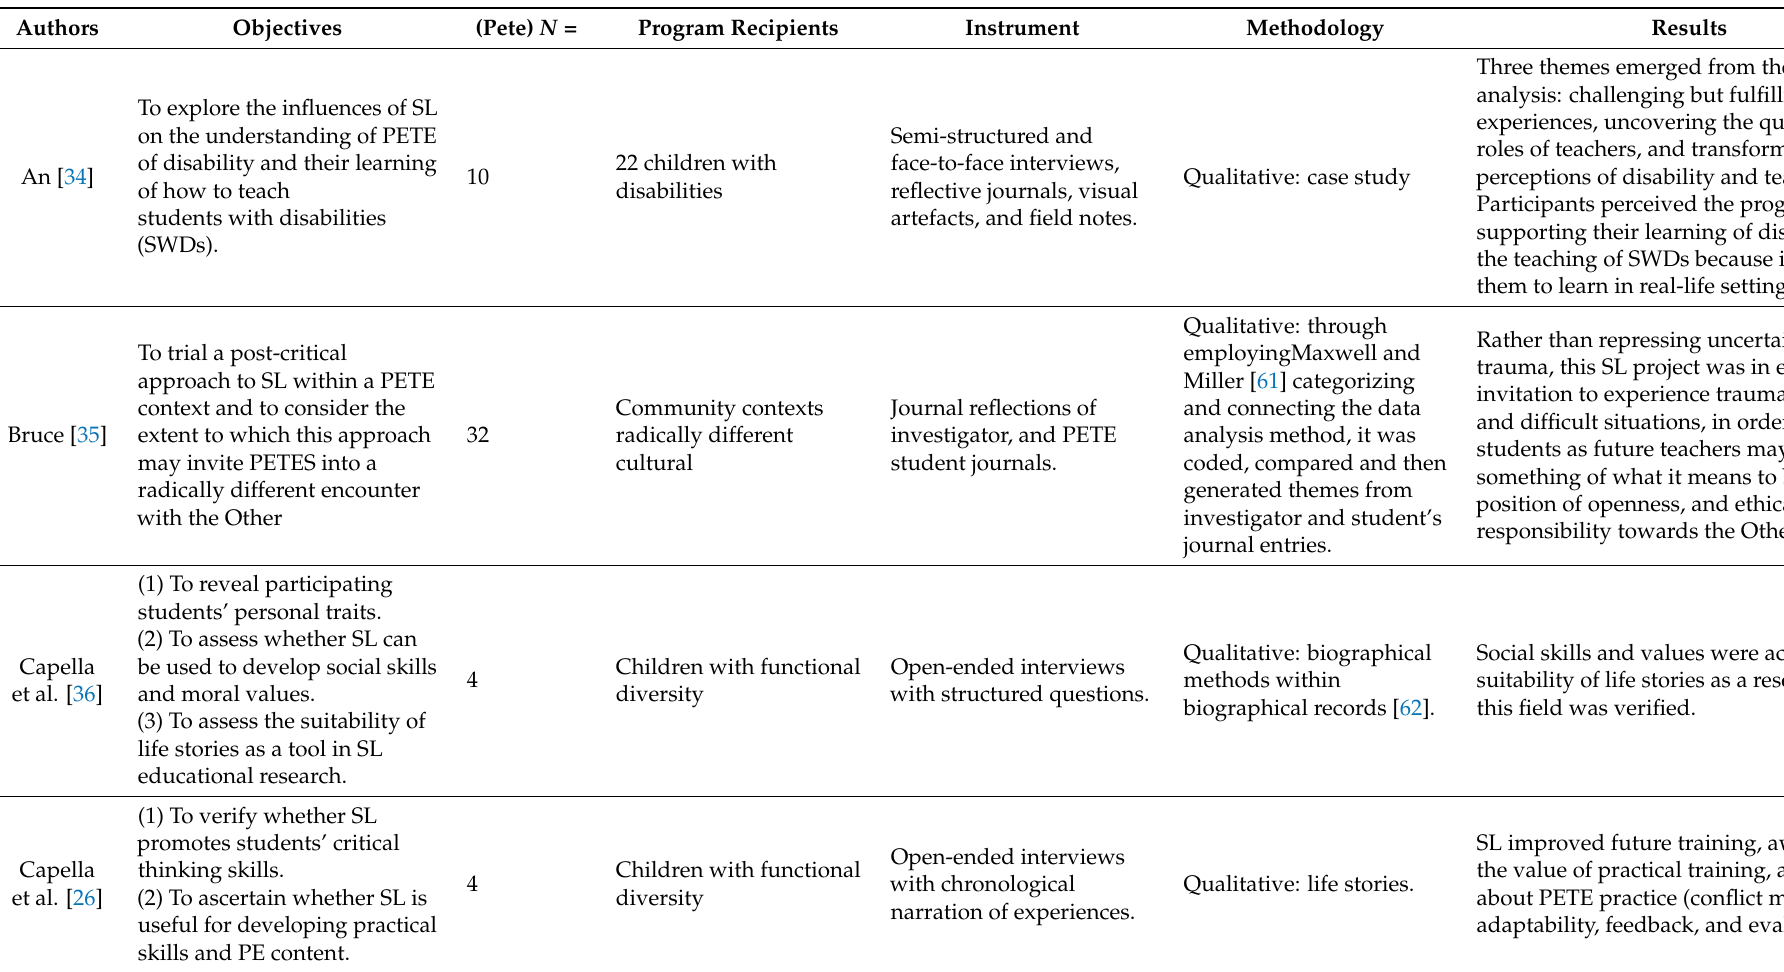
Table 3. General overview of the literature